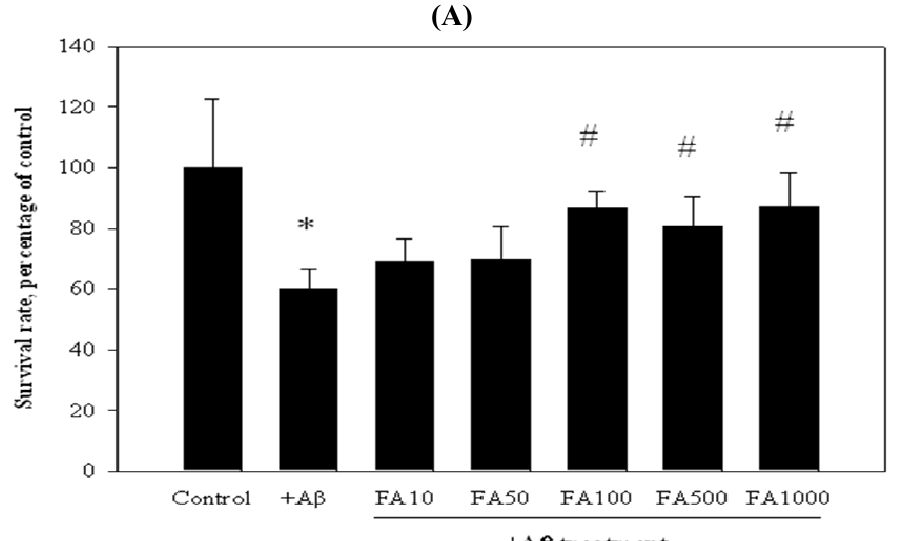
Figure 2. Effects of folic acid (FA) or newly synthesized bioactive compounds (NSCs) on β -amyloid (A β ) -induced (25-35)